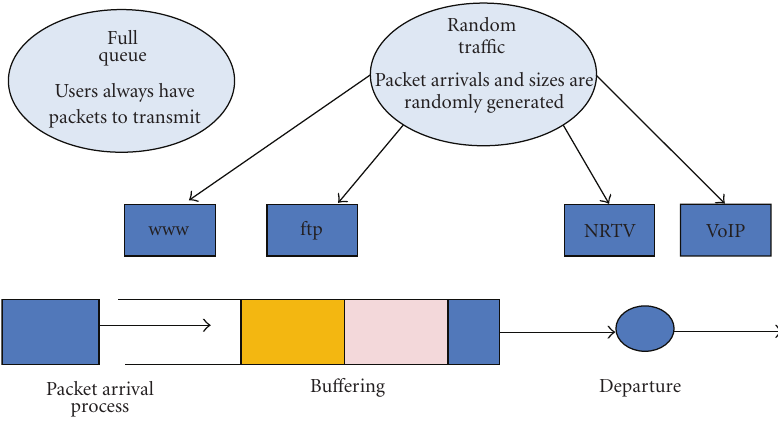
Figure 3: Tra ffi c models.